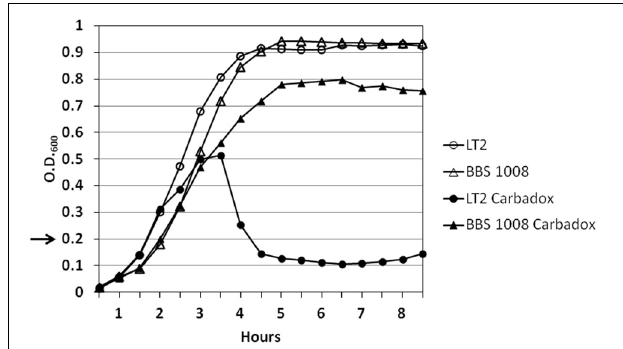
FIGURE 2 | Carbadox exposure of wild-type S. Typhimurium LT2 results in bacterial cell lysis. S. Typhimurium strains (LT2 and BBS 1008) were grown in LB glucose medium at 37 ◦ C with shaking. At OD 600 = 0 . 2 (arrow), carbadox (2.5 μ g/ml) was added to cultures indicated by the closed symbols. The open symbols indicate control cultures without